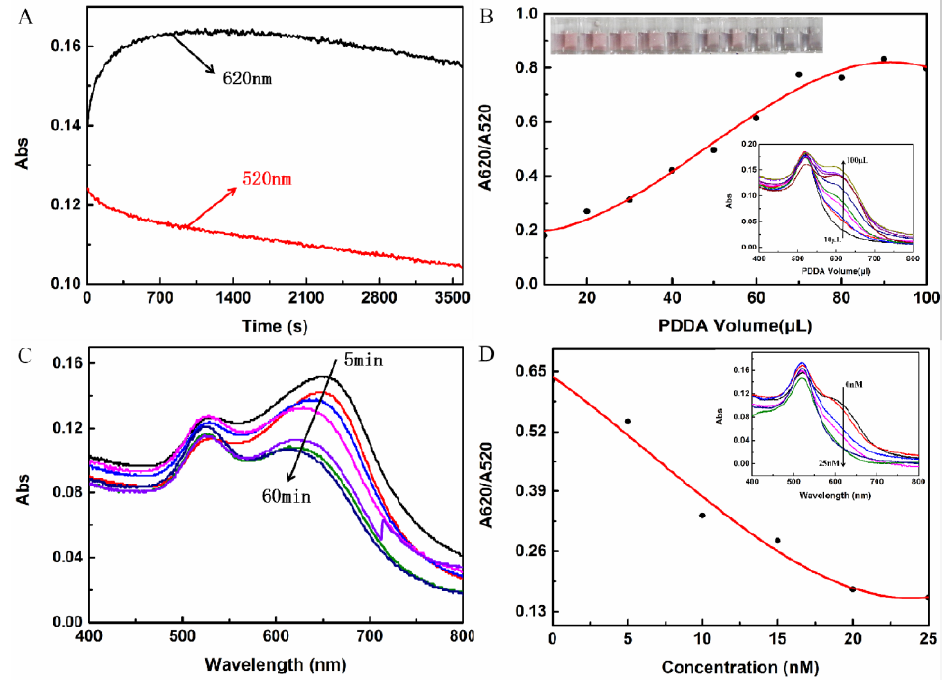
Figure 3. Effect of ( A ) incubation time after the addition of AuNPs, ( B ) PDDA dosage, ( C ) aptamer and PDDA incubation time, and ( D ) aptamer concentration (nM).